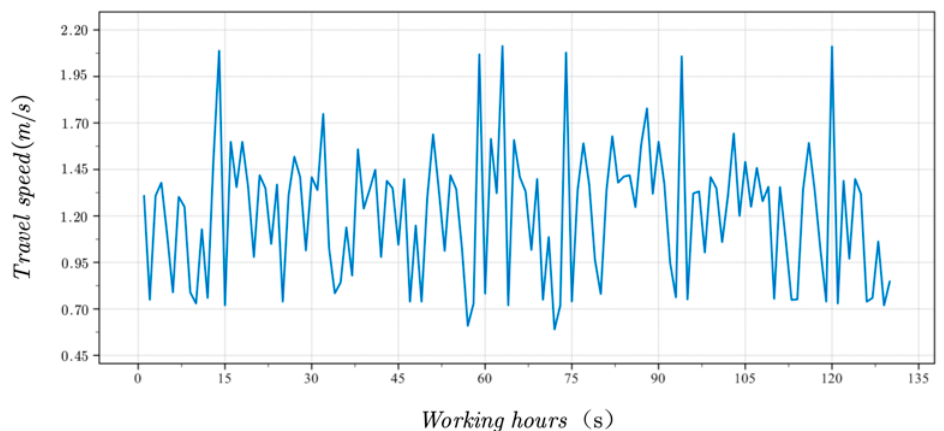
Figure 17. Time domain diagram of traveling speed.